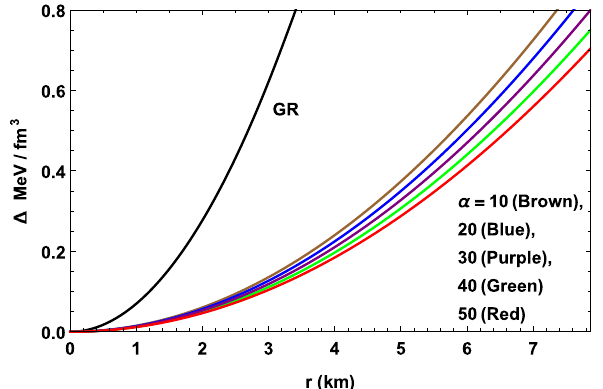
Fig. 6 Variation of gravitation red-shift for 4U 1538-52 using the parameter provided in Table